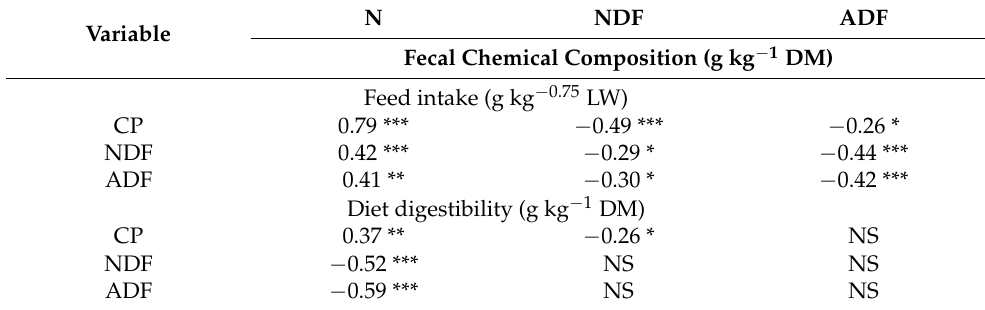
Table 5. Pearson’s correlation coefficients and significance levels between fecal chemical composition and feed intake, ingesta composition and diet digestibility across experiment 1 and experiment 2 data sets.